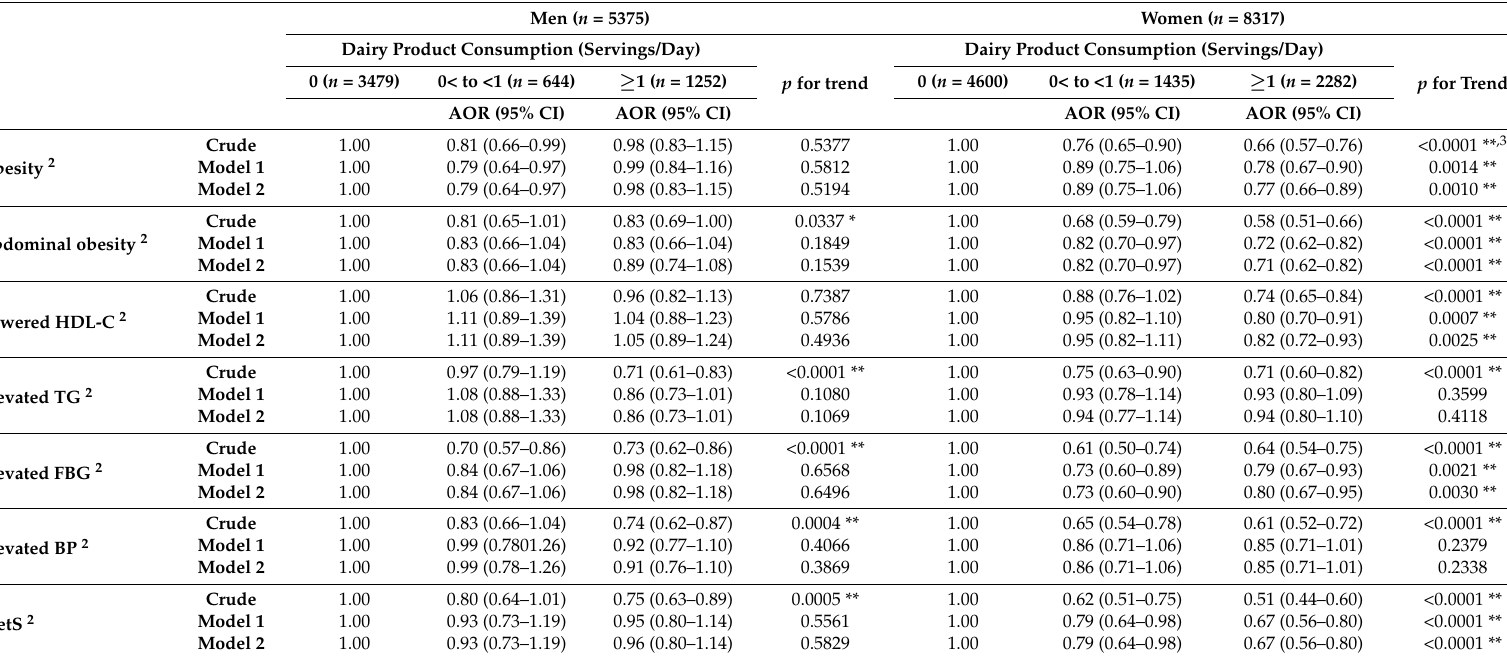
Table 5. The adjusted odds ratios (AORs) and 95% confidence intervals (CIs) for obesity and MetS risk factors according to dairy product consumption in Korean adults, KNHANES 2010–2013 1